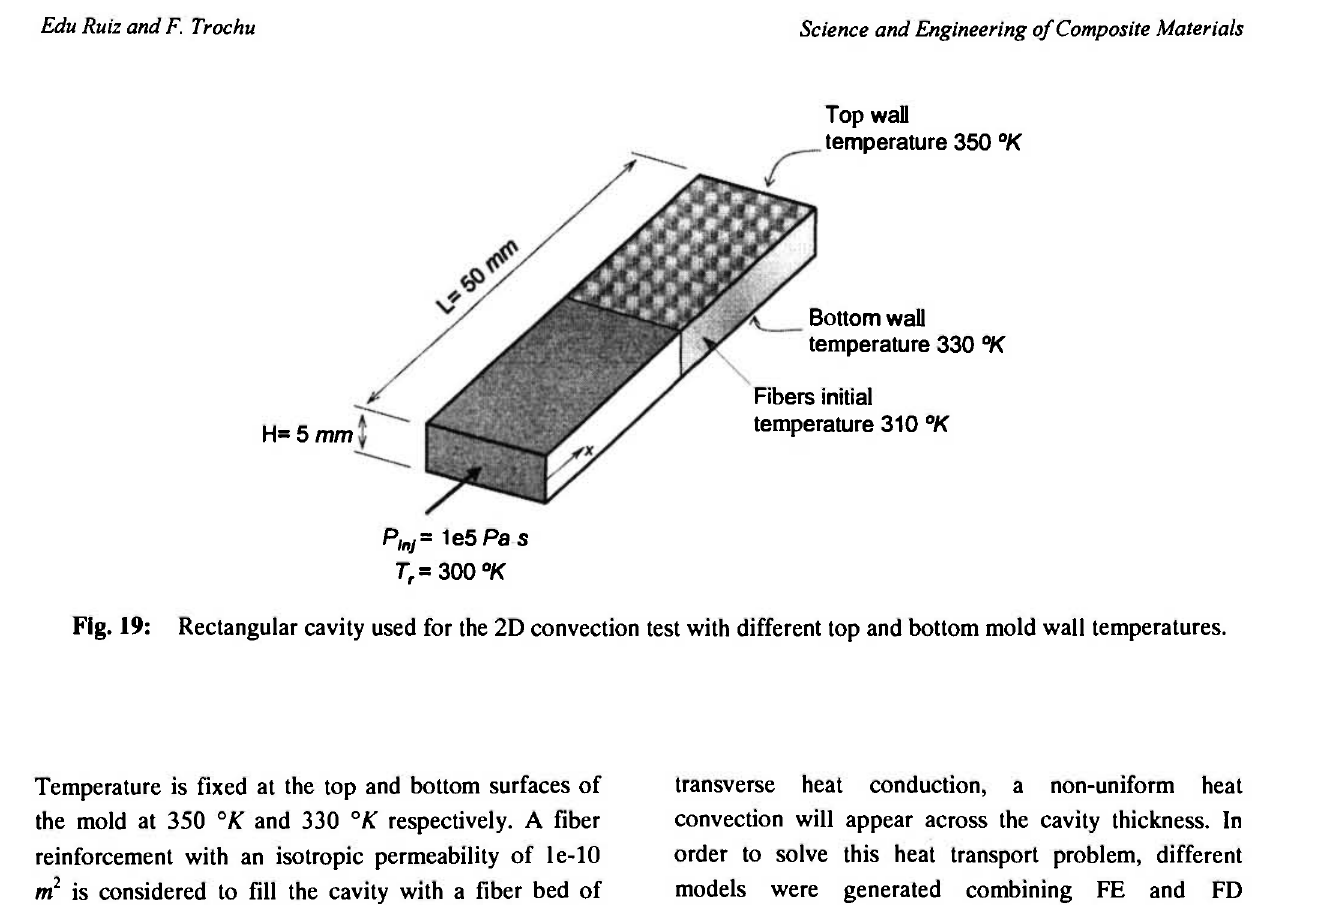
Combination of different formulations and elements used for test case